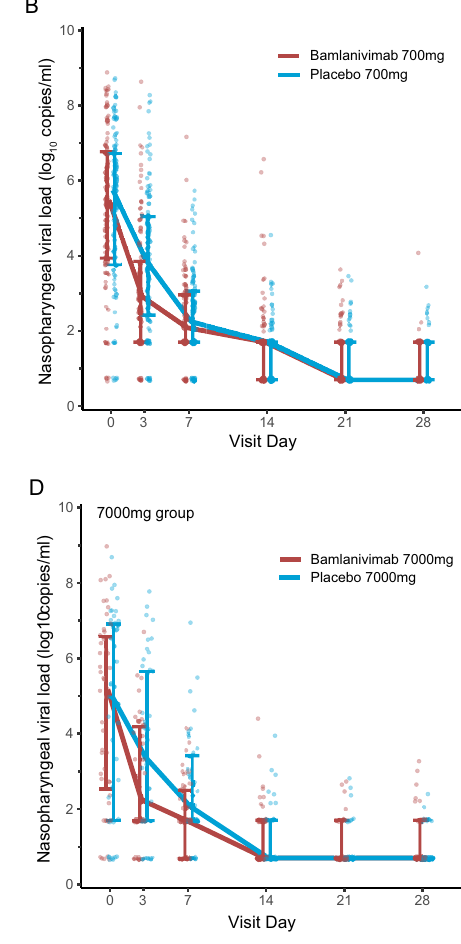
with an independence working correlation structure. Median NP viral loads were lower at day 3 for bamlanivimab 700mg vs placebo (2.9 vs 3.9 log 10 copies/mL, p =0.002)( B ),withsimilar fi ndingsseen,thoughnotstatisticallysigni fi cant,forthe smaller7000mg dosecohort(2.2vs3.4log 10 copies/mL, p =0.07)( D ).SeeTable3 for quantitative SARS-CoV-2 RNA levels at later time points. P-values for compar- ison of median NP viral loads were generated by two-sided Wilcoxon tests. No adjustment was made for multiple comparisons. The lower limit of detection was 1.4 log 10 copies/mL. Presented in B and D are median values with error bars for interquartile ranges, and individual participant values as dots. The bamlanivimab arm is representedby the color orange and placebo by the color blue.Source Data for summary measures are provided as a Source Data fi